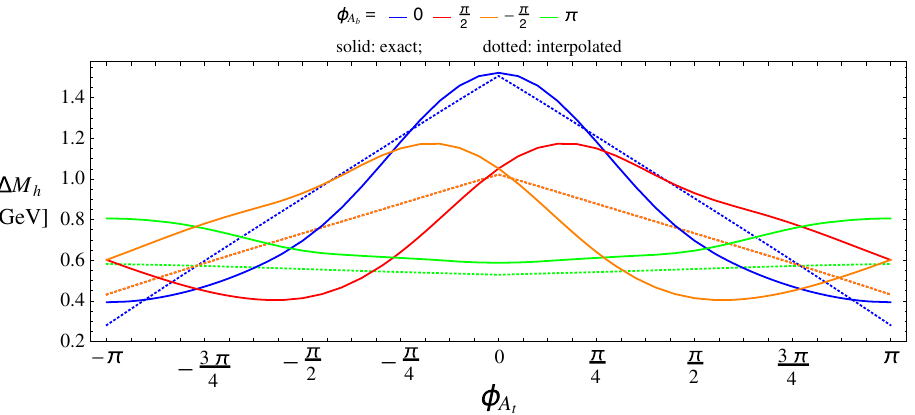
Fig. 7 Dependence of the lightest Higgs-mass shift (cid:7) M h on φ A FeynHiggs , the red-dotted and orange-dotted lines are